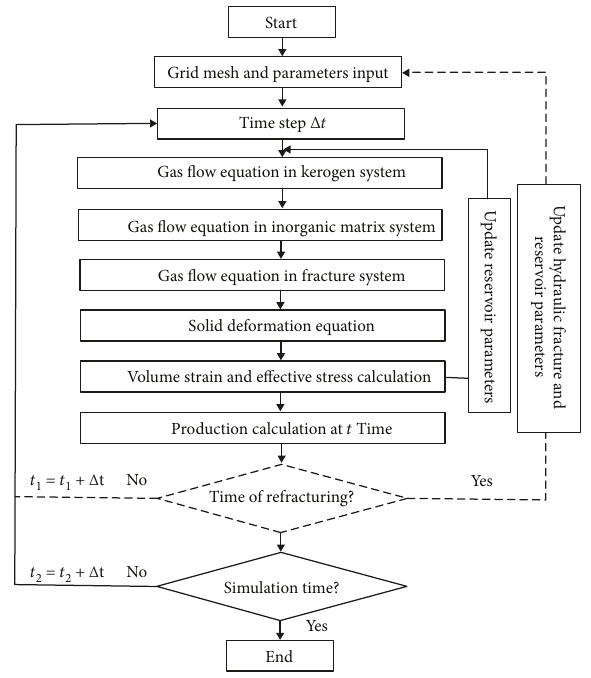
Figure 1: Simulation procedure of modeling initial fracturing and refracturing